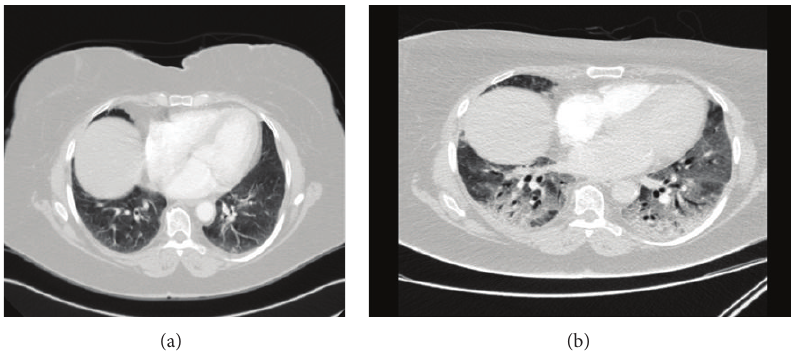
Figure 1: (a) Chest CT scan of patient 1, three months prior to symptoms of pneumonitis. (b) Chest CT scan of patient 1, at the beginning of respiratory symptoms: diffuse interstitial infiltrates and ground glass opacities shown in both lung fields.